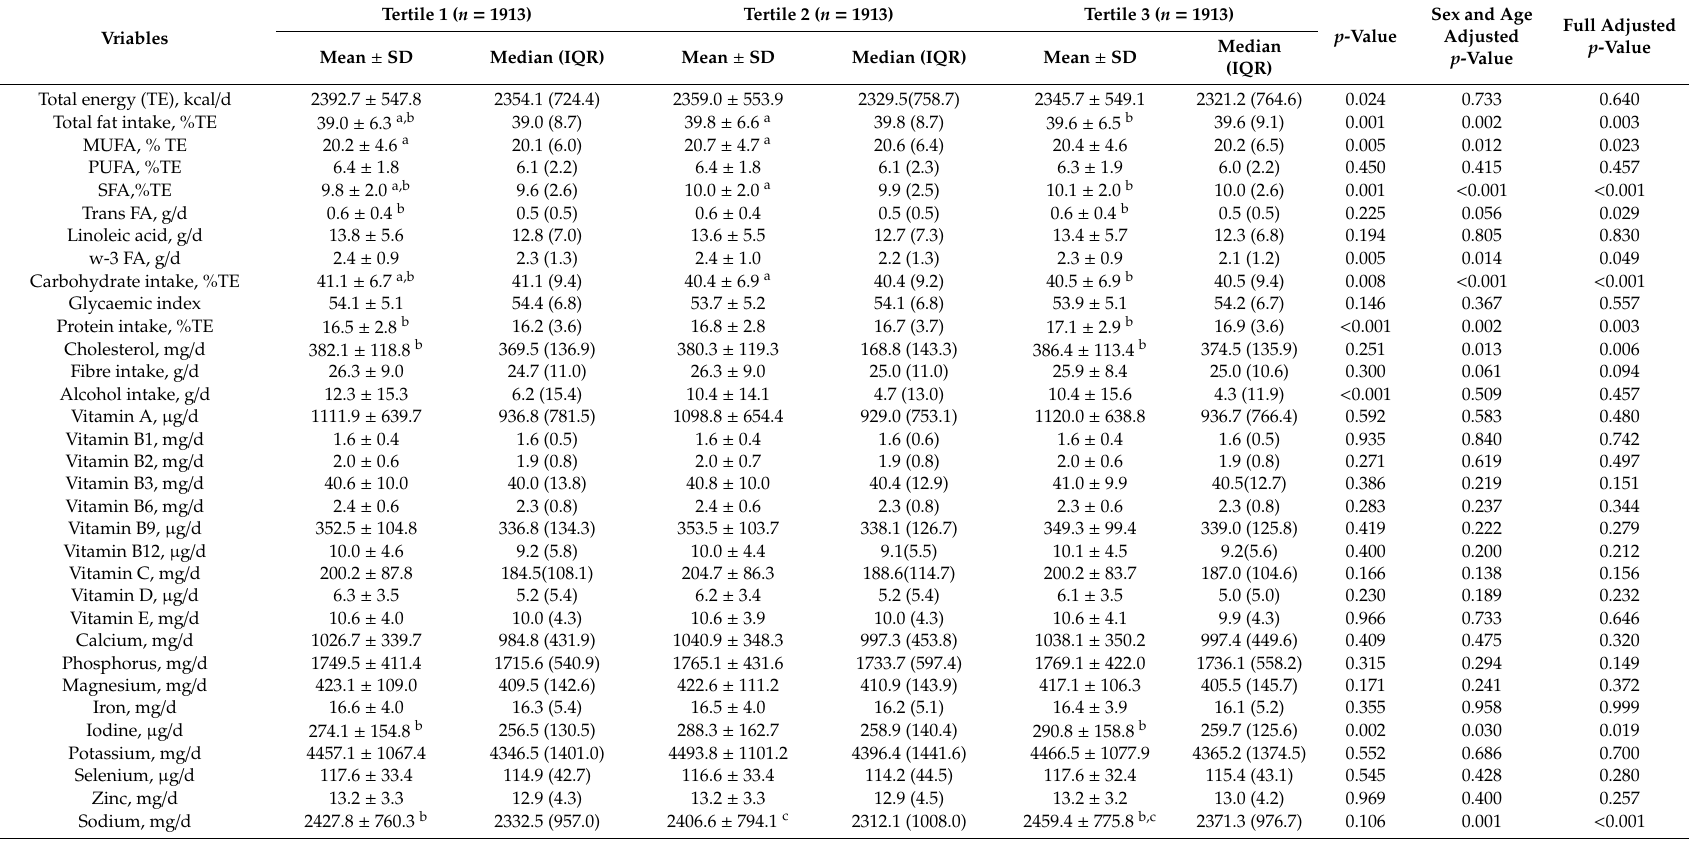
Table 4. Energy and nutrient intake according to tertiles of Metabolic Syndrome Severity Score